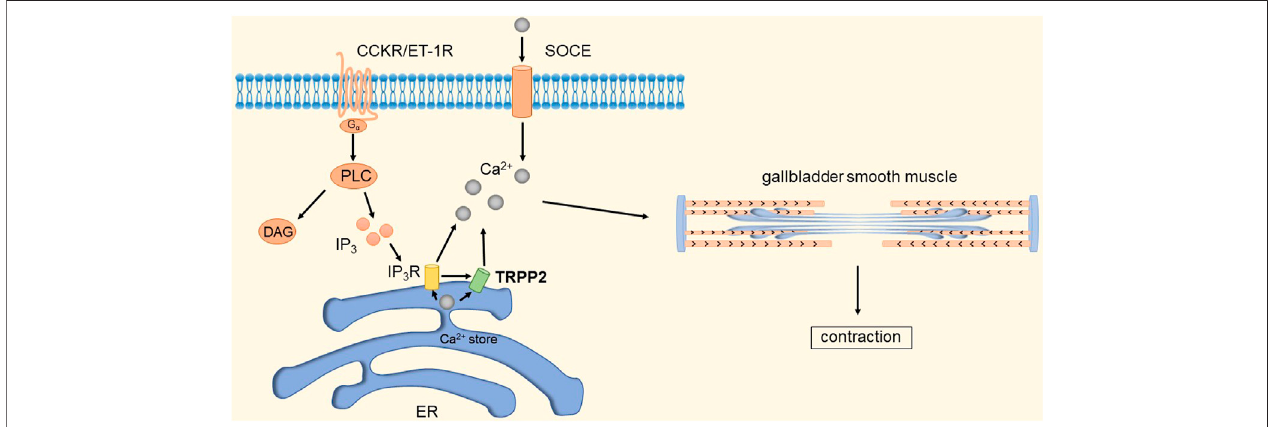
FIGURE11| TRPP2mediates gallbladder smoothmusclecontraction.CCK andET-1 receptors canactivate PLCand guide thehydrolysis ofphosphatidylinositol 4,5-bisphosphate to produce diacylglycerol and IP3. IP3 increases local [Ca 2+ ] i by activating IP3R to release Ca 2+ from Ca 2+ stores, which in turn activates TRPP2 to cause further release of Ca 2+ . Depletion of Ca 2+ stores will subsequently initiate SOCE. The increase in [Ca 2+ ] i causes contraction of gallbladder smooth